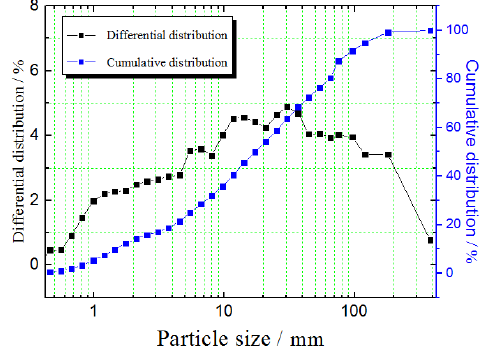
Figure 1. Unclassified tailings particle size distribution.